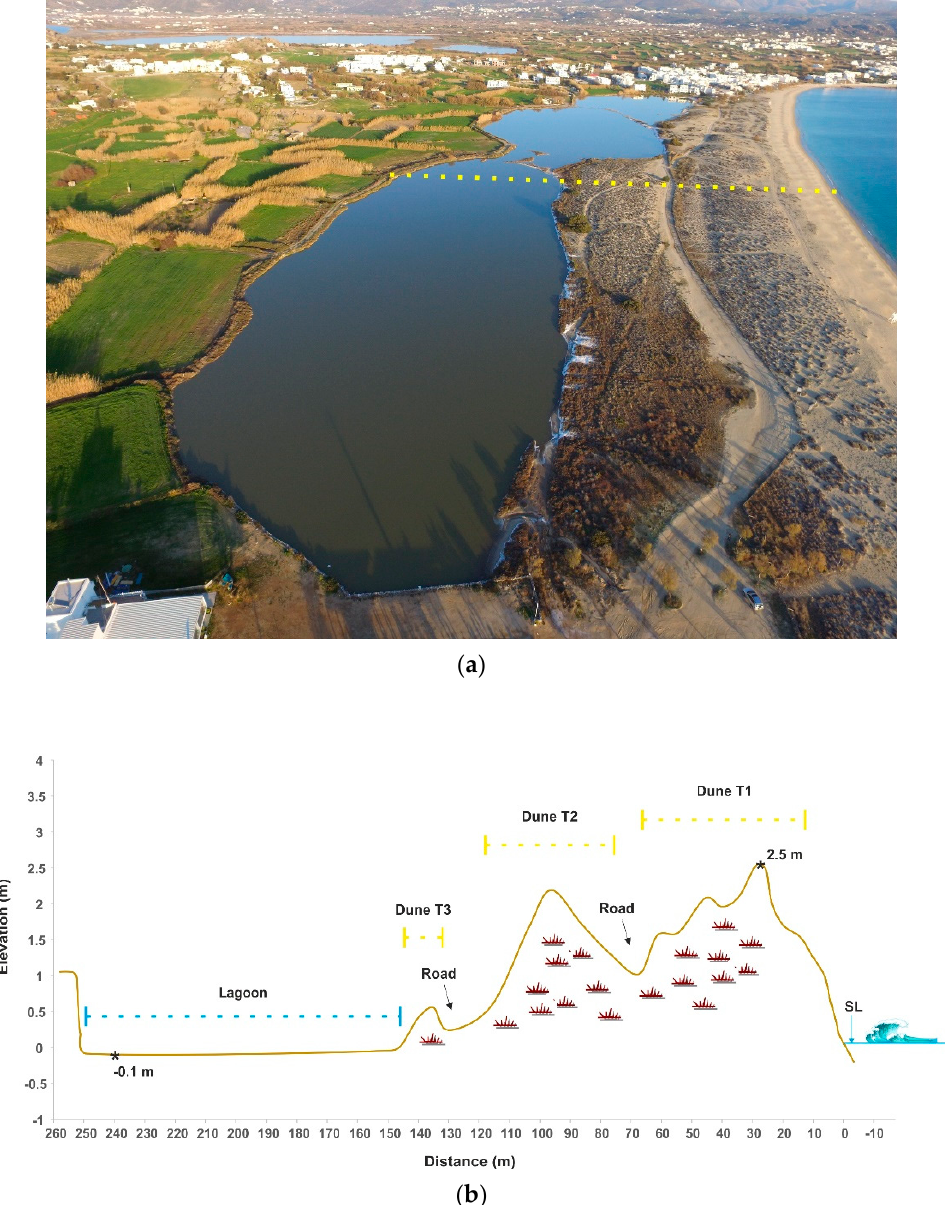
Figure 5. ( a ) Aerial photograph of Agios Prokopios dunes and lagoonal system, with the location of the cross section; ( b ) Cross section of Agios Prokopios site.